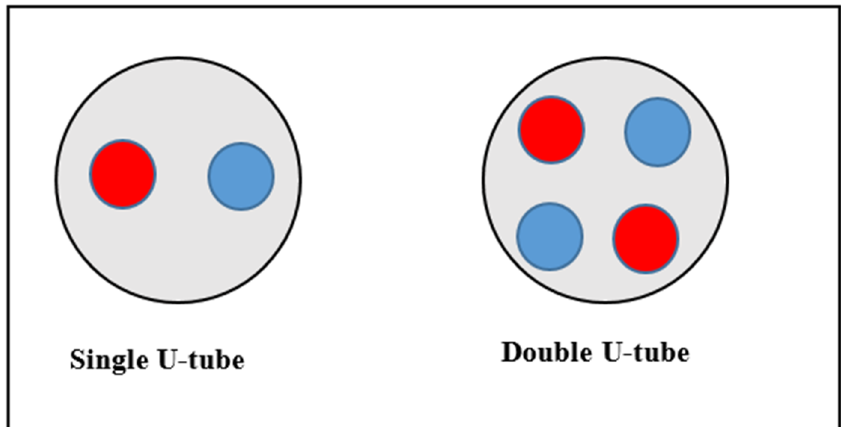
Figure 4. Cross section of the commonly used vertical heat exchanger designs.